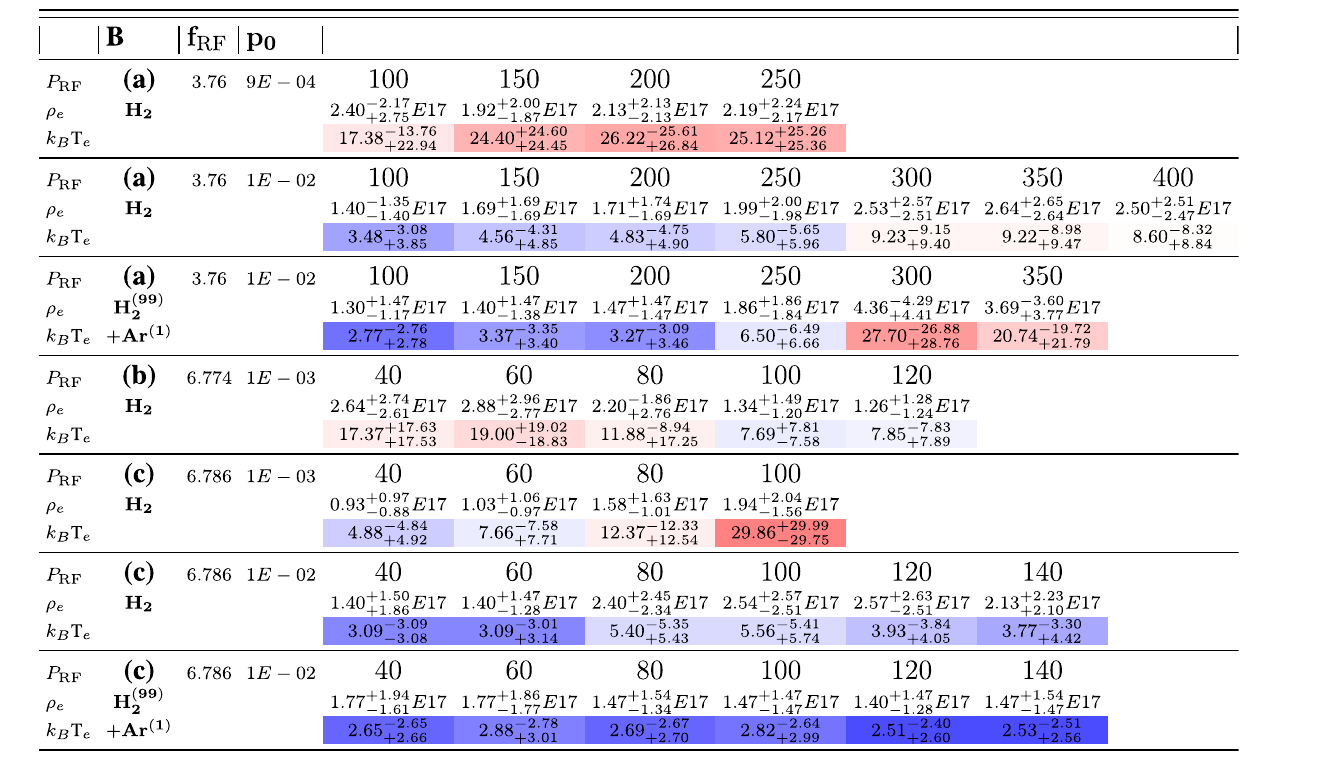
TABLE4Plasmaparameters( electrondensity ρ e [m − 3 ],andenergy k B T e [eV]),estimatedfromOESmeasurementsfordifferentexperimentalcon fi gurations,intermsof B- fi eld (Injection,Mid,andExtraction coil polarized current) [(a): 240 A, 0 A, 180 A; (b): 448 A, 45 A, 350 A; (c): 410 A, − 80 A, 345 A], RF frequency ( f RF [GHz]), gas pressure p 0 [mbar], and RF power P RF [W]. Gradient-color (red – white – blue) provides indications on the energy (temperature) gradient ( hotter, colder) for the many con fi gurations explored. Gas-mixture cases are explicitly reported in the